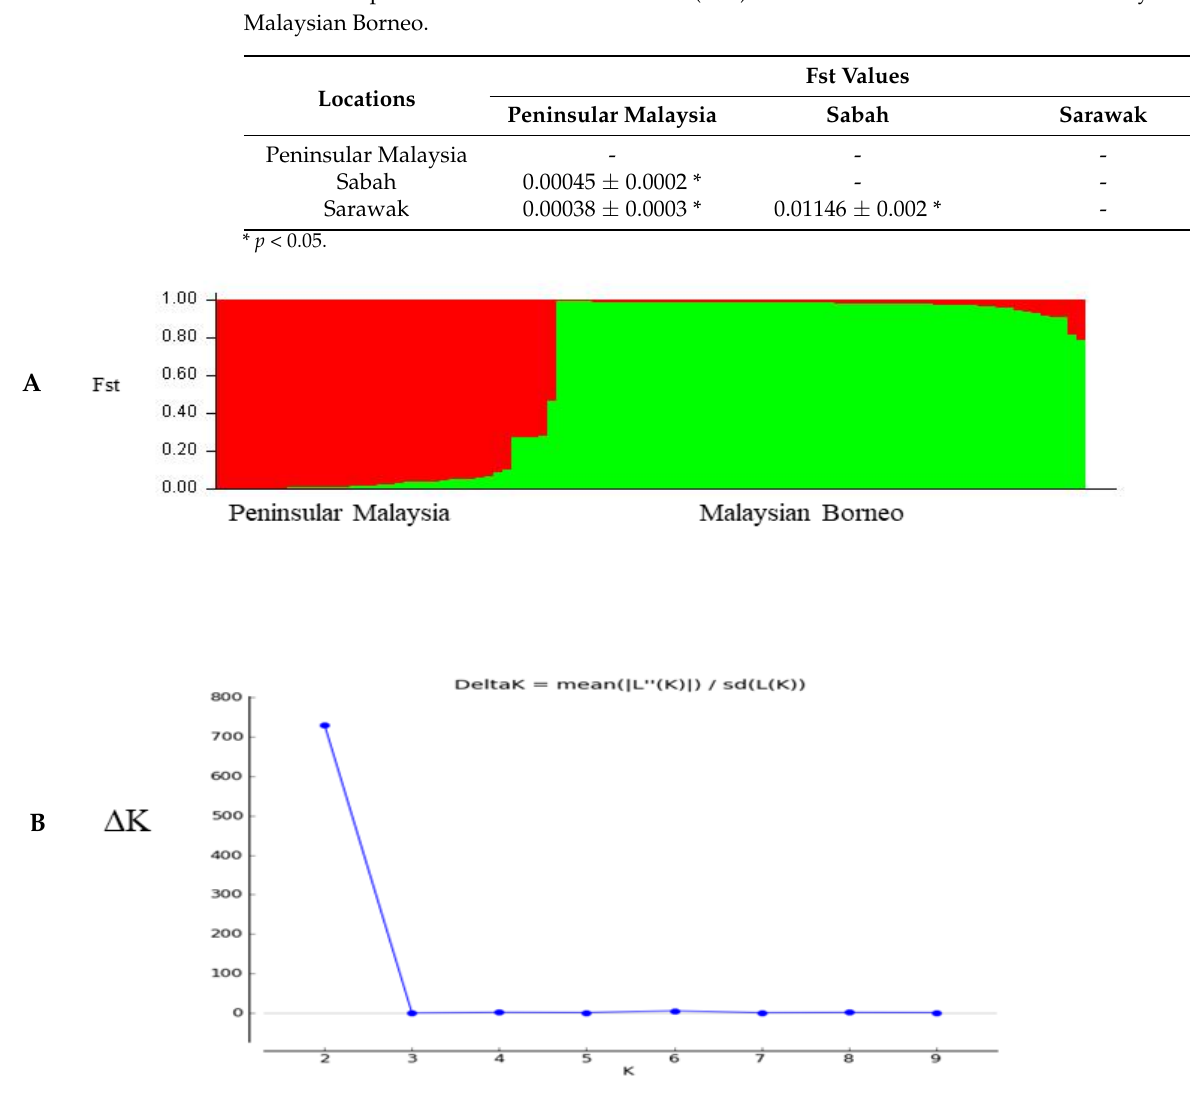
Figure 6. ( A ) Most likely number of parasite sub-populations (K = 2) based on PkTRAMP gene within 97 samples from different regions of Malaysia. ( B ) The number of sub-populations was estimated by the delta K value ( ∆ K), and two distinct sub-populations were observed (K = 2, ∆ K = 730). The line graph of population structure is shown using membership coefficients (Q values).